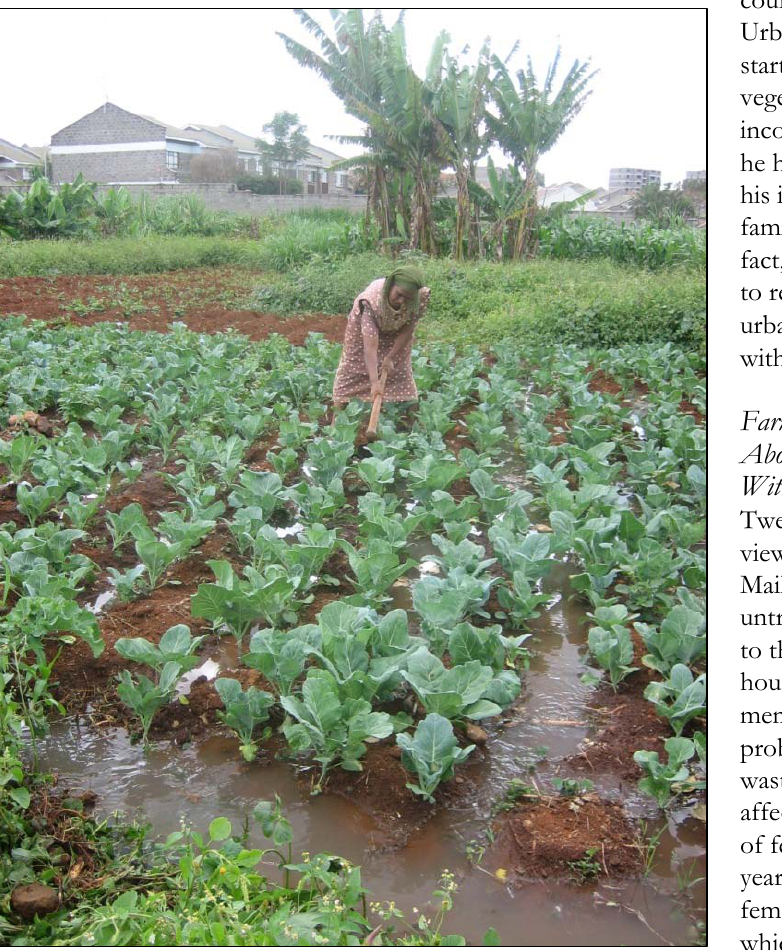
Figure 2. Ruth Weeding Vegetables Irrigated Using Wastewater in Nairobi, May